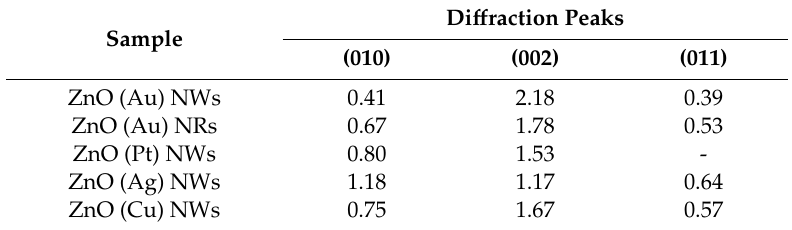
Table 3. The texture coe ffi cient values of 1D ZnO nanostructures using di ff erent